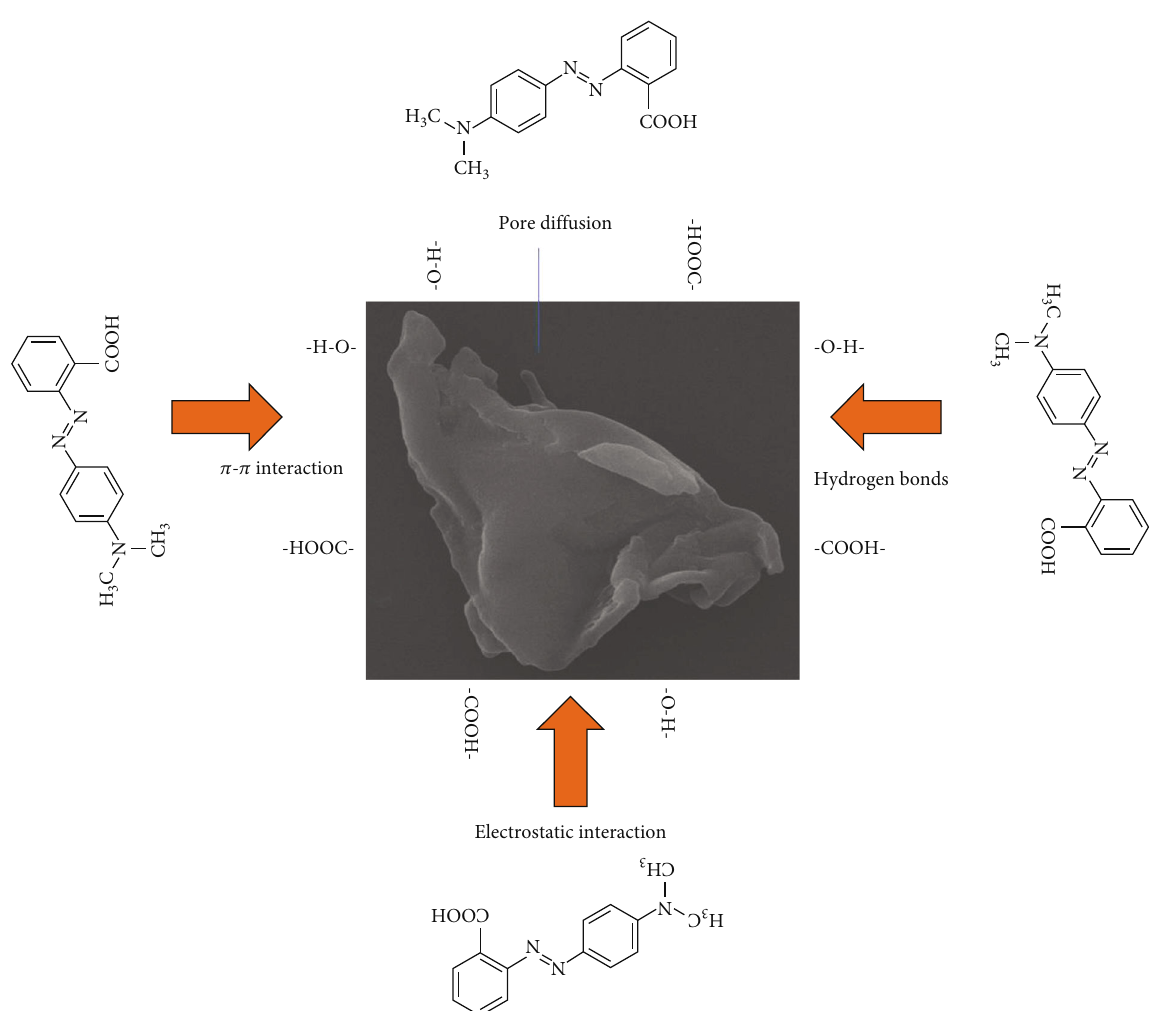
Figure 12: Summary of possible adsorption mechanism of methyl red dye on the fl oral waste